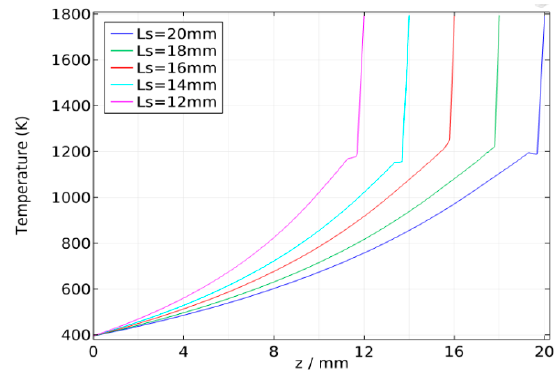
Figure 9. Wire temperature distribution.